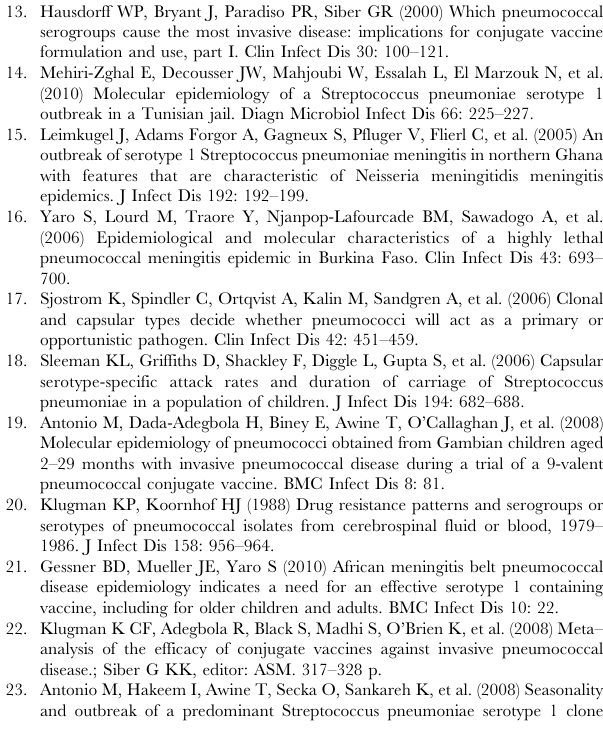
Table S3 Accessory regions in PNI0373. The presence or absence of previously identified pneumococcal regions of diversi- ty/accessory regions was assessed for both PNI0373 and P1031 [71–75]. The presence or absence of accessory regions was determined using BLASTN and BLASTP searches of AR sequences and genes encoded within AR. The criteria to define AR as present ( + ), partial ( + / 2 ) or absent ( 2 ) is as follows: (a) present ( + ) if greater than 85% of region sequence and/or genes encoded in region were present in a conserved/syntenic block; (b) partial ( + / 2 ) if between 25–85% of region sequence and/or encoded genes in block present; anc (c) absent ( 2 ) if less than 25% of region sequence and/or encoded genes